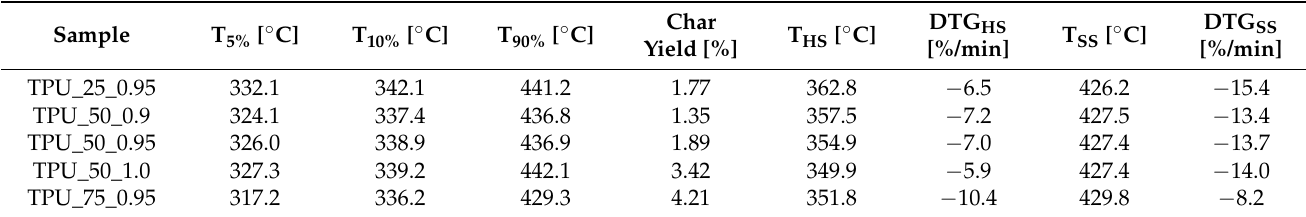
Table 2. Thermal characteristic of synthesized thermoplastic polyurethanes based on TG